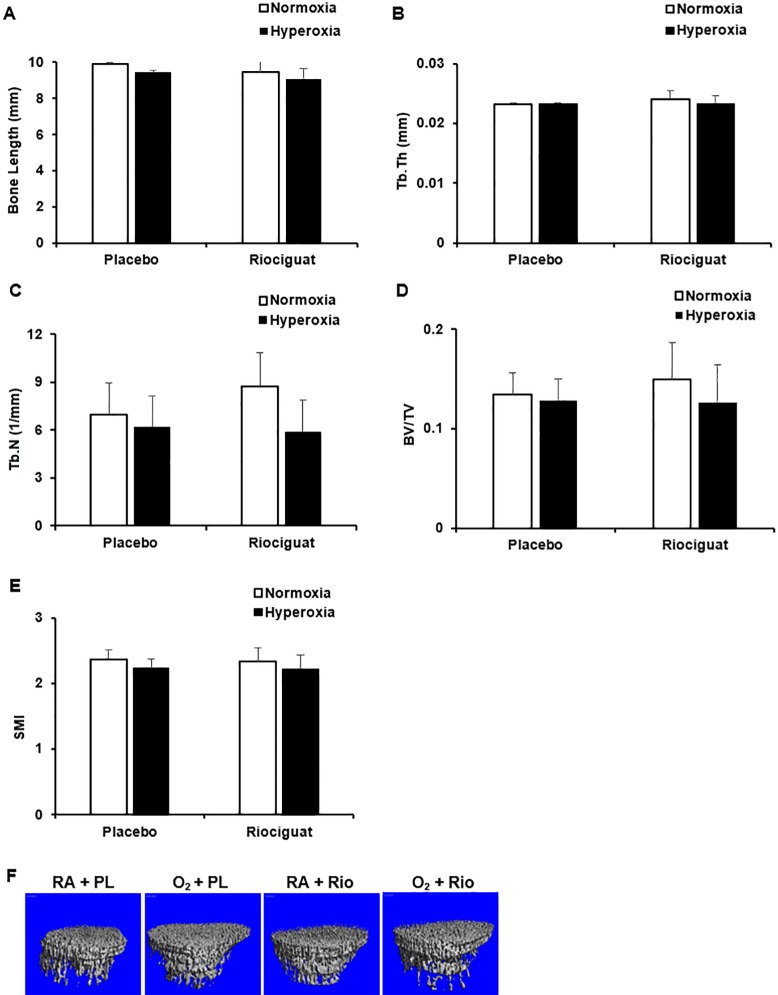
Riociguat does not affect femur growth and structure.(A) Bone length. (B) Trabecular thickness (Tb.Th). (C) Trabecular number (Tb.N). (D) Bone volume fraction (BV/TV). (E) Structural model index (SMI). (F) Representative micro-CT images. n = 5/group.